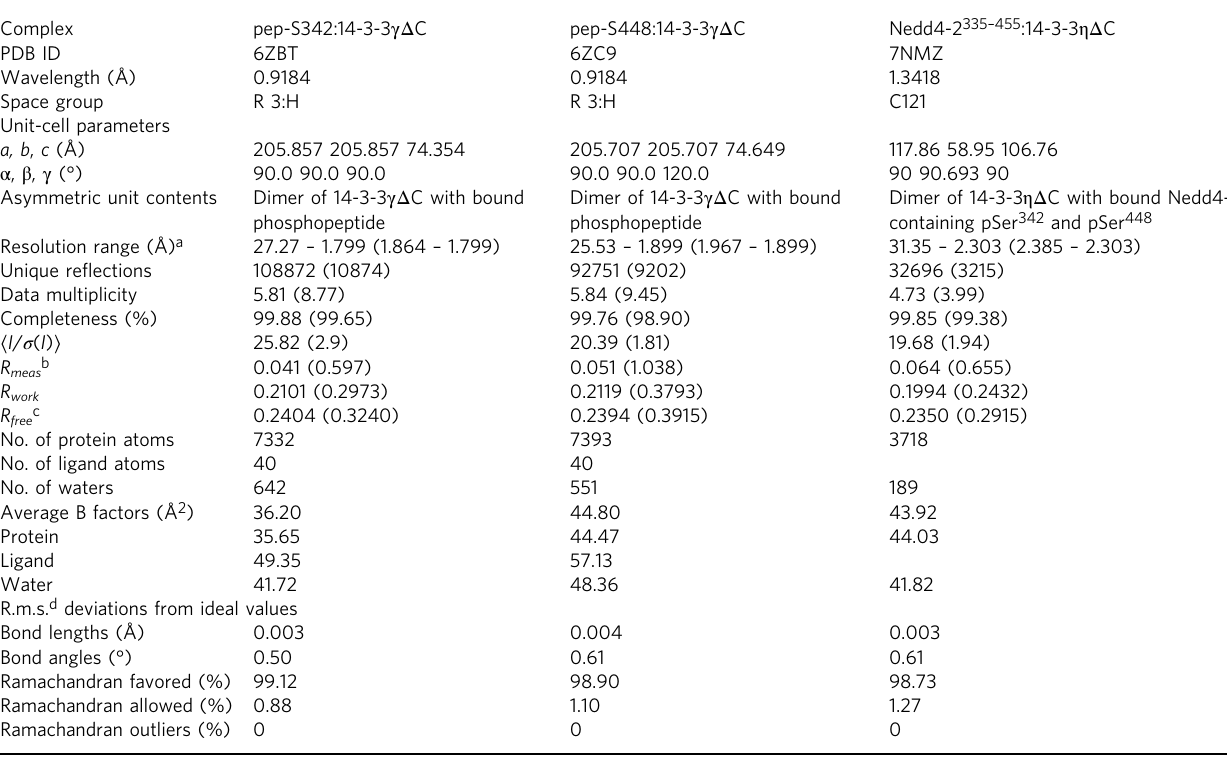
Table 2 Crystallographic data collection and re fi nement